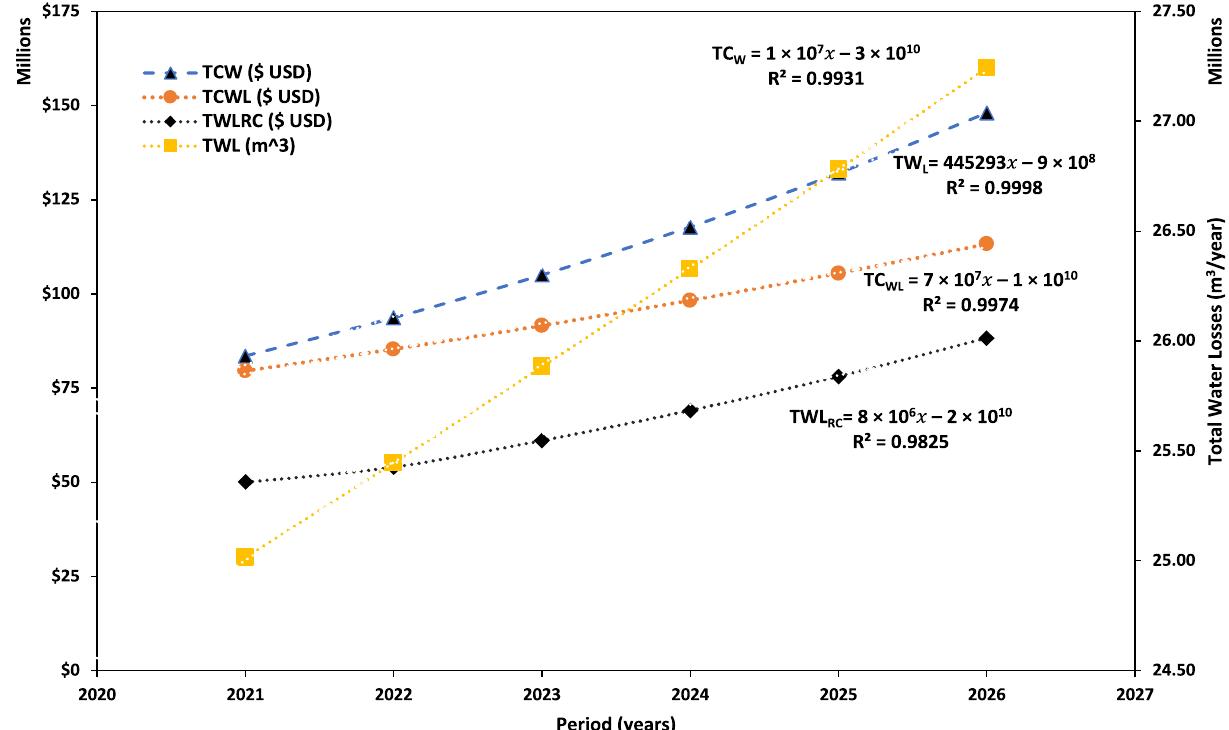
Figure 5. Graphical results of the integrated total cost method. TCW: total cost of water, TCWL: total cost of water losses, TWLRC: total water loss reduction cost, TWL: total water loss.